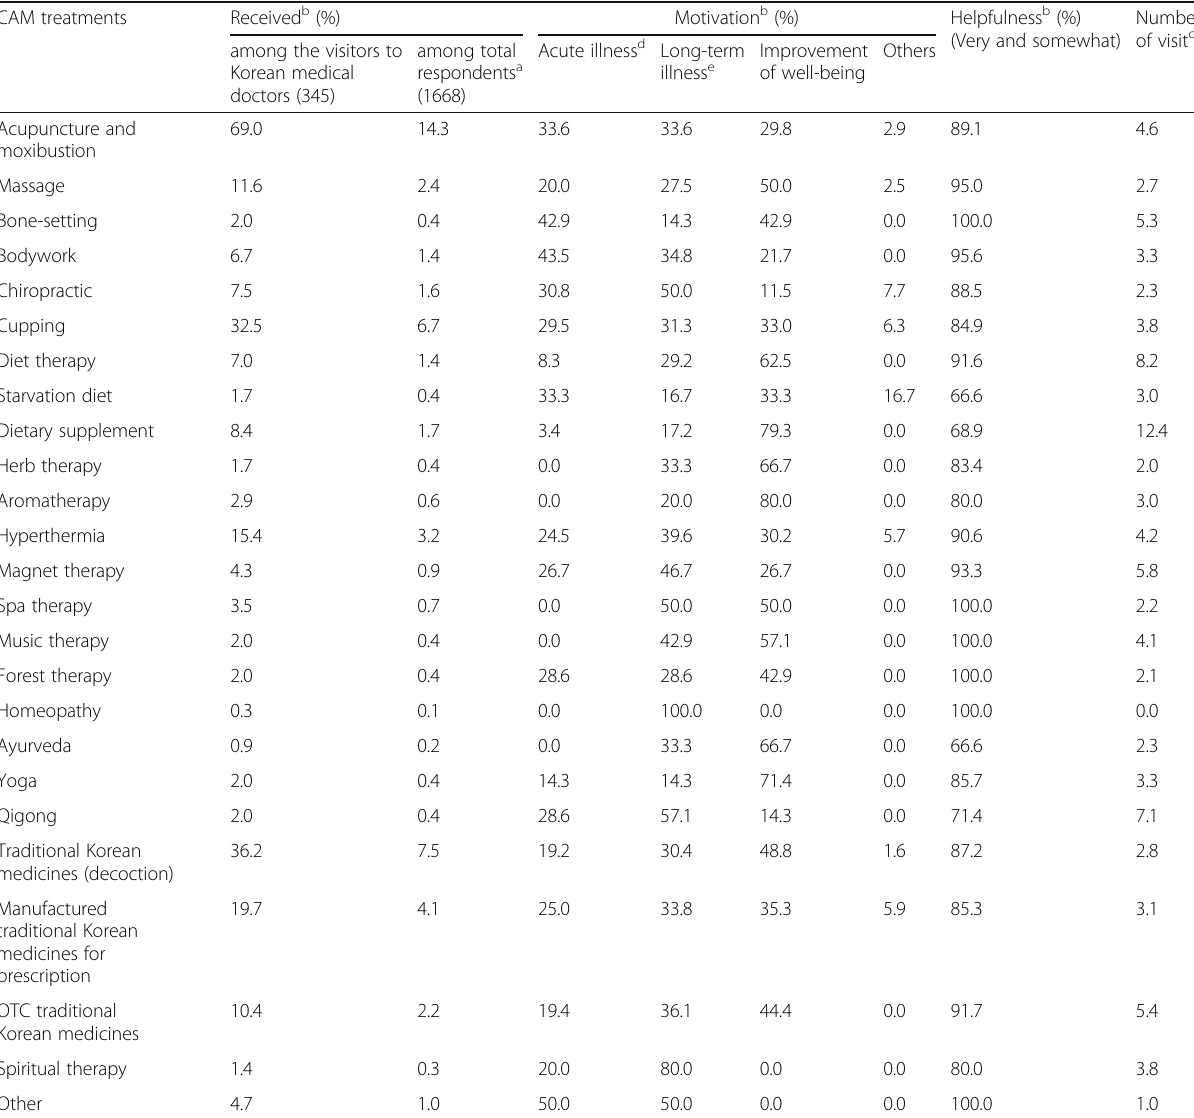
Table 4 CAM treatments received by practice or advices of Korean medical doctors CAM